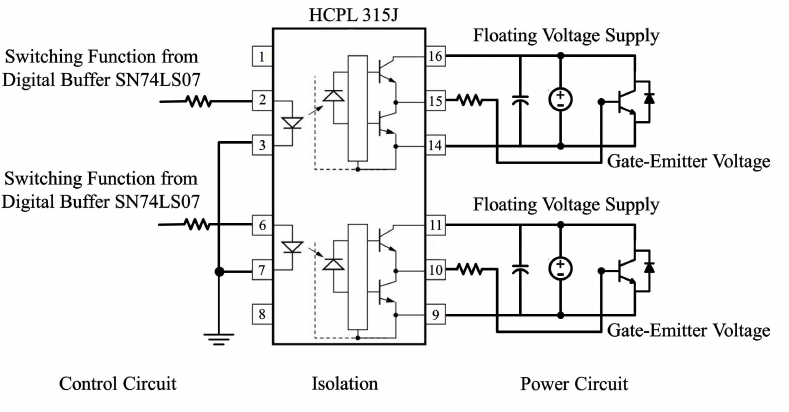
Figure 7. Typical electrical circuit as the IGBT optocoupler gate